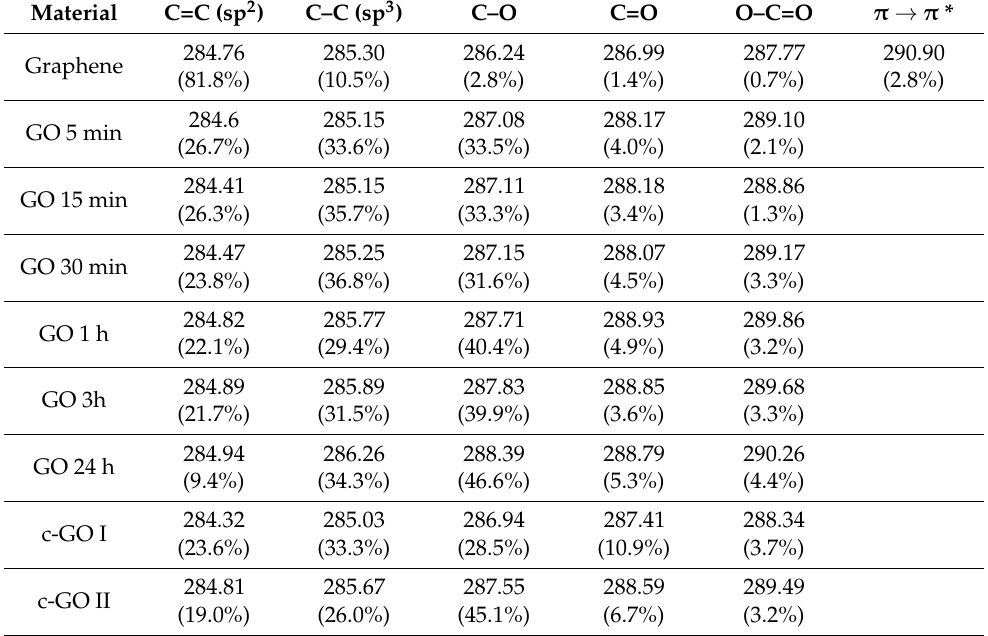
Table 1. Binding energy of the deconvoluted XPS C1s peaks and their relative percentage areas (in parentheses) for the spectra shown in Figure 2 and Figure